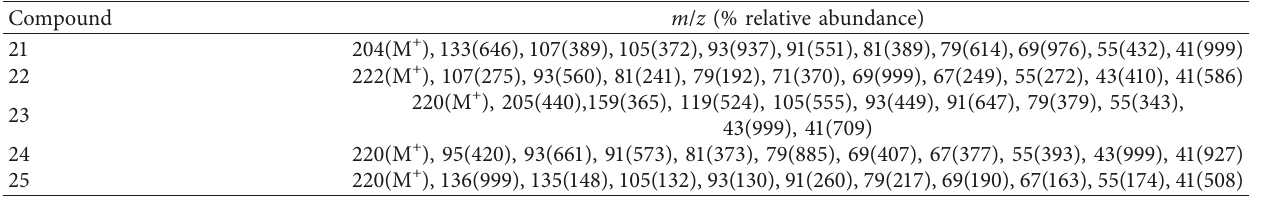
Table 20: Mass spectra of compounds 26–30 of whole plant n -hexane fraction of Achillea wilhelmsii (WHFAW). Compound